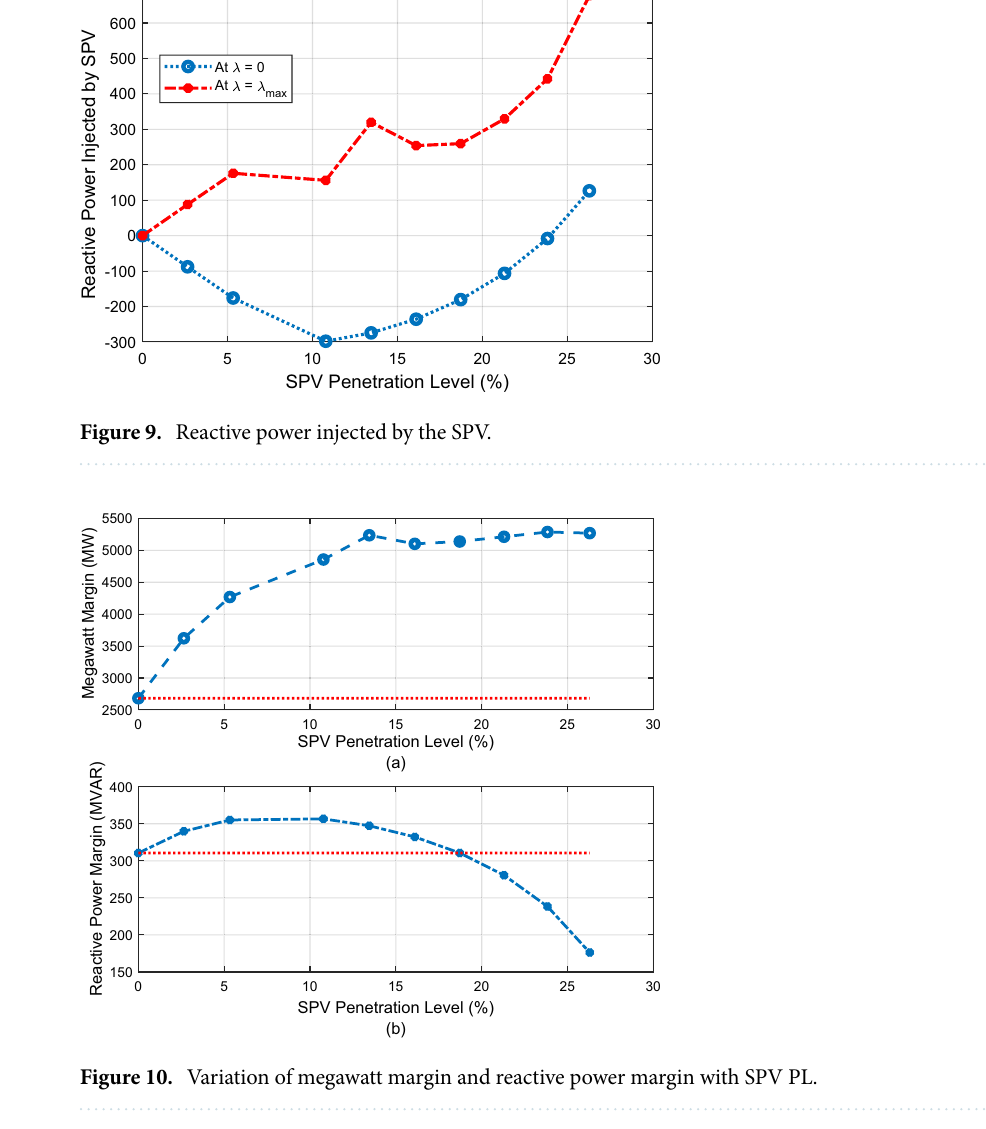
figure indicates the original base case value. The RPM falls to a value of 176.3MVAR at the last investigated SPV PL of 26.29%. The corresponding CVQR of the system associated with the minimum RPM is shown in Fig. 11. The figure shows that the voltage stability of the system is initially improved as indicated by CVQR value becoming less negative. However, the CVQR begins to become more negative after 10.78% SPV PL, and returns to its original value at about 25.6% SPV PL. It can be observed from Figs. 10 and 11 that although the loadability of the system is increasingly enhanced with increasing SPV PL as indicated by the MWM of the system, the RPM and the CVQR of the system declines at higher SPV PL, thereby showing that the system tends toward voltage instability at higher SPV PL. Solar PV located at weakest buses in the northern region. In this case, the SPV is dispersed across the weak Northern buses. SPVs are located in Jalingo, Maiduguri, Yola, Gombe, Damaturu, Kano, Jos, Kaduna and Birnin- Kebbi in an incremental manner. The Solar PV integration ranges from 100 MW (2.65% PL) to 1800 MW (46.81% PL) for this case. Figure 12 shows the variation of the highest bus voltage with respect to the SPV PL. The figure depicts that the highest bus voltage decreases as the SPV PL increases. The bus voltage criterion of 1.0 ± 0.05 p.u is achieved at about 21.44% PL (about 800 MW). Thus, with 200 MW SPV integration at Jalingo, Maiduguri, Yola and Gombe each, a satisfactory voltage profile can be attained, with additional advantages as compared to the use of shunt reactors. As observed from Fig. 12, SPV PL of 13.49% (500 MW) at three locations will ensure that no bus voltage exceeds 1.102 p.u, which is the maximum performance obtained from the use of shunt reactors at five locations as discussed in “Scenario 2: shunt reactors applied in five locations” section.